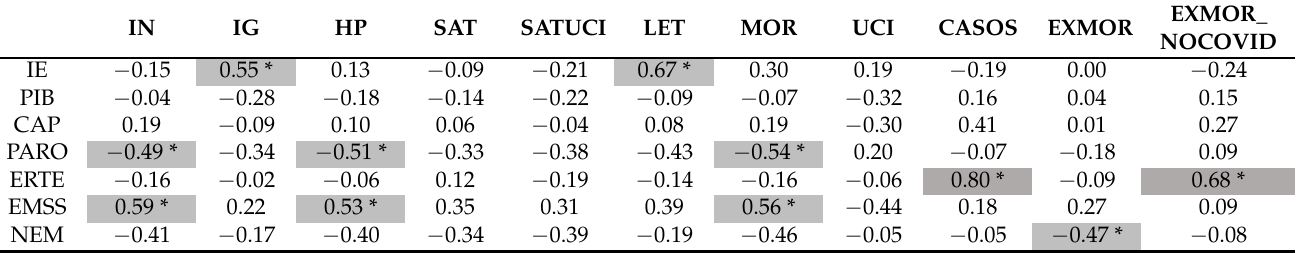
Table 2. Correlations between socioeconomic and epidemiological indicators. 2020